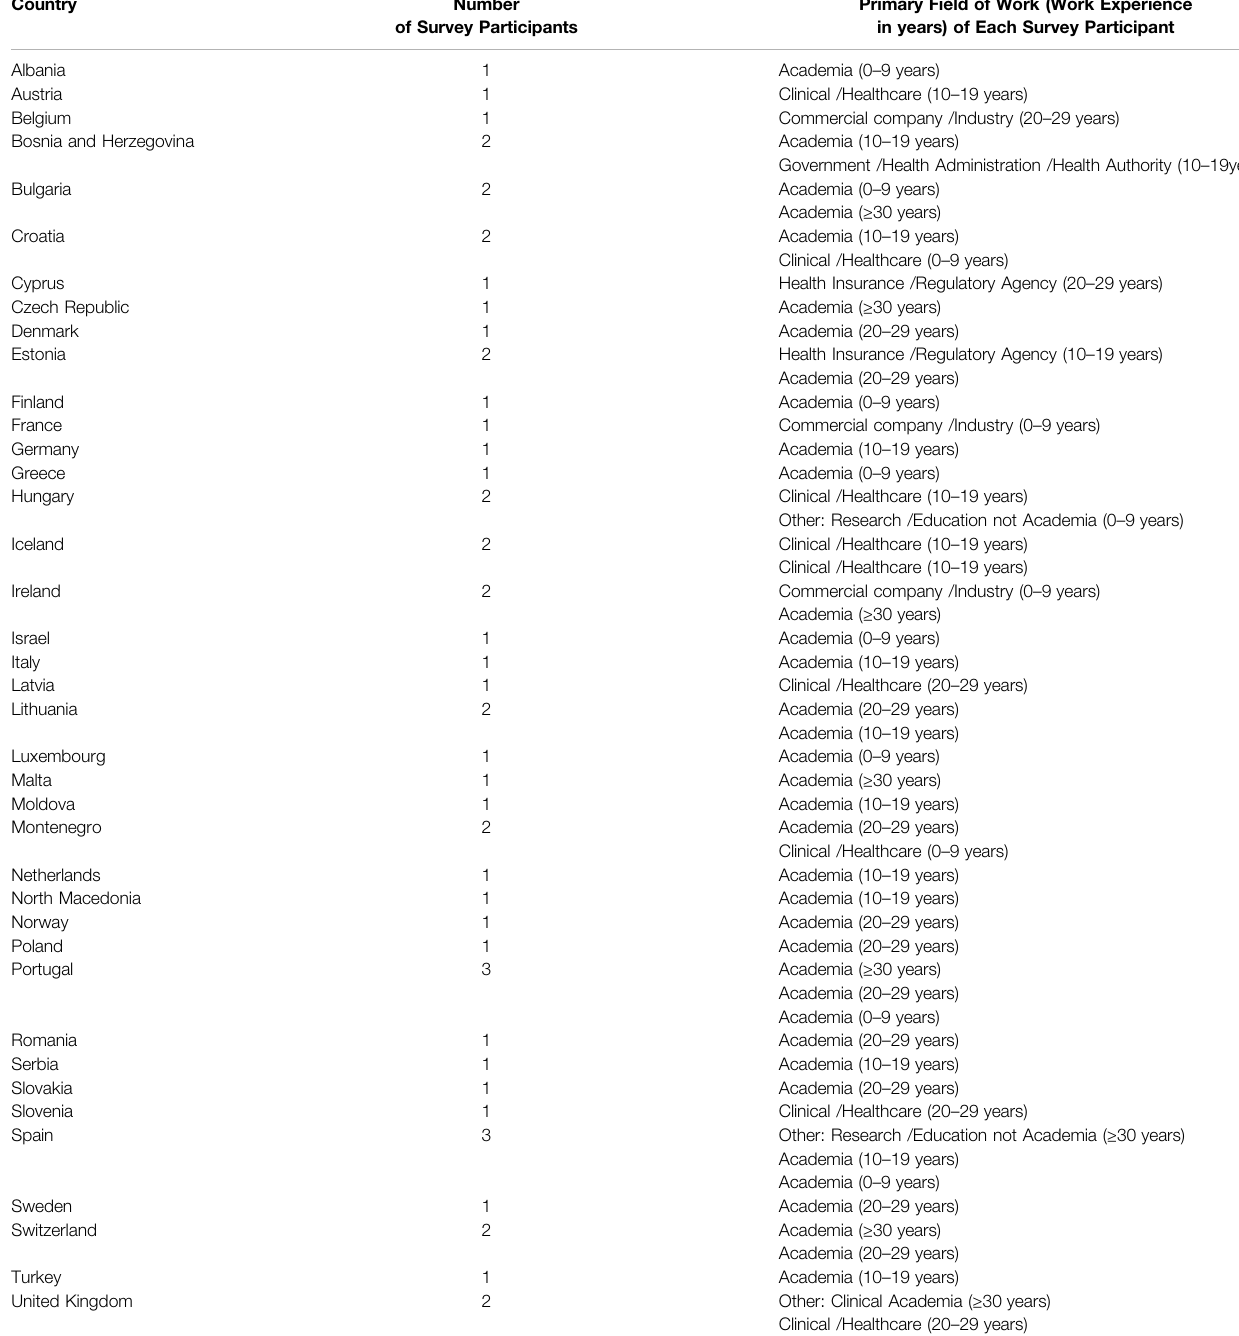
TABLE 1 | General characteristics of survey